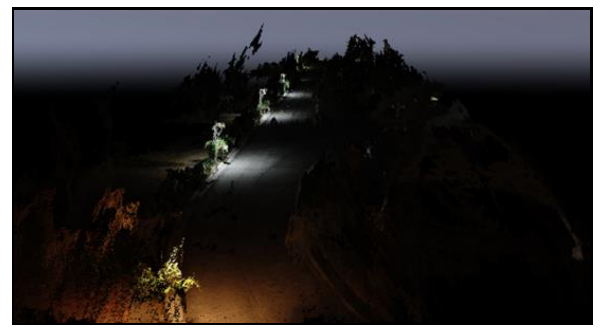
Figure 5. 3D Model of the subject area.